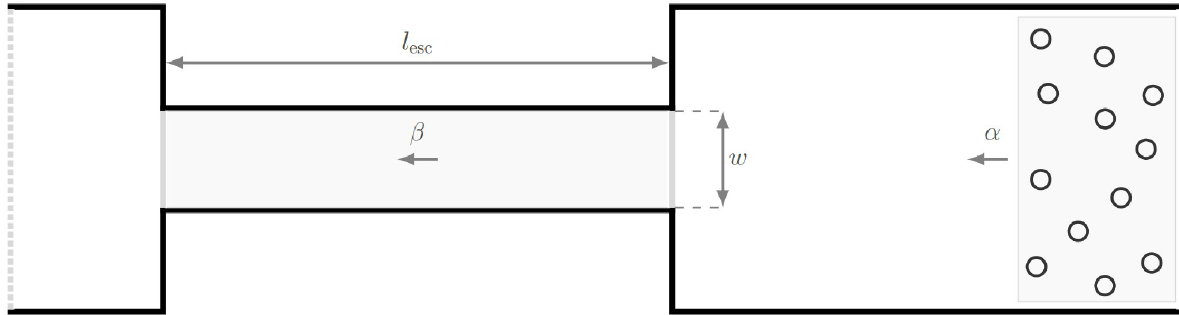
Fig 2. Geometry used for the simulations. The geometry consists of three parts: a lower floor including the agent sources (right), an escalator with a clear width of w 2 {0.6, 1.0}m, and a projected horizontal length of l esc = 10 m (middle), as well as an upper floor which is located Δ h = 5 m above the lower one (left). The movement direction of the agents and of the escalator is from right to left. The incoming agent flow α can be freely adjusted whereas the flow β is typically